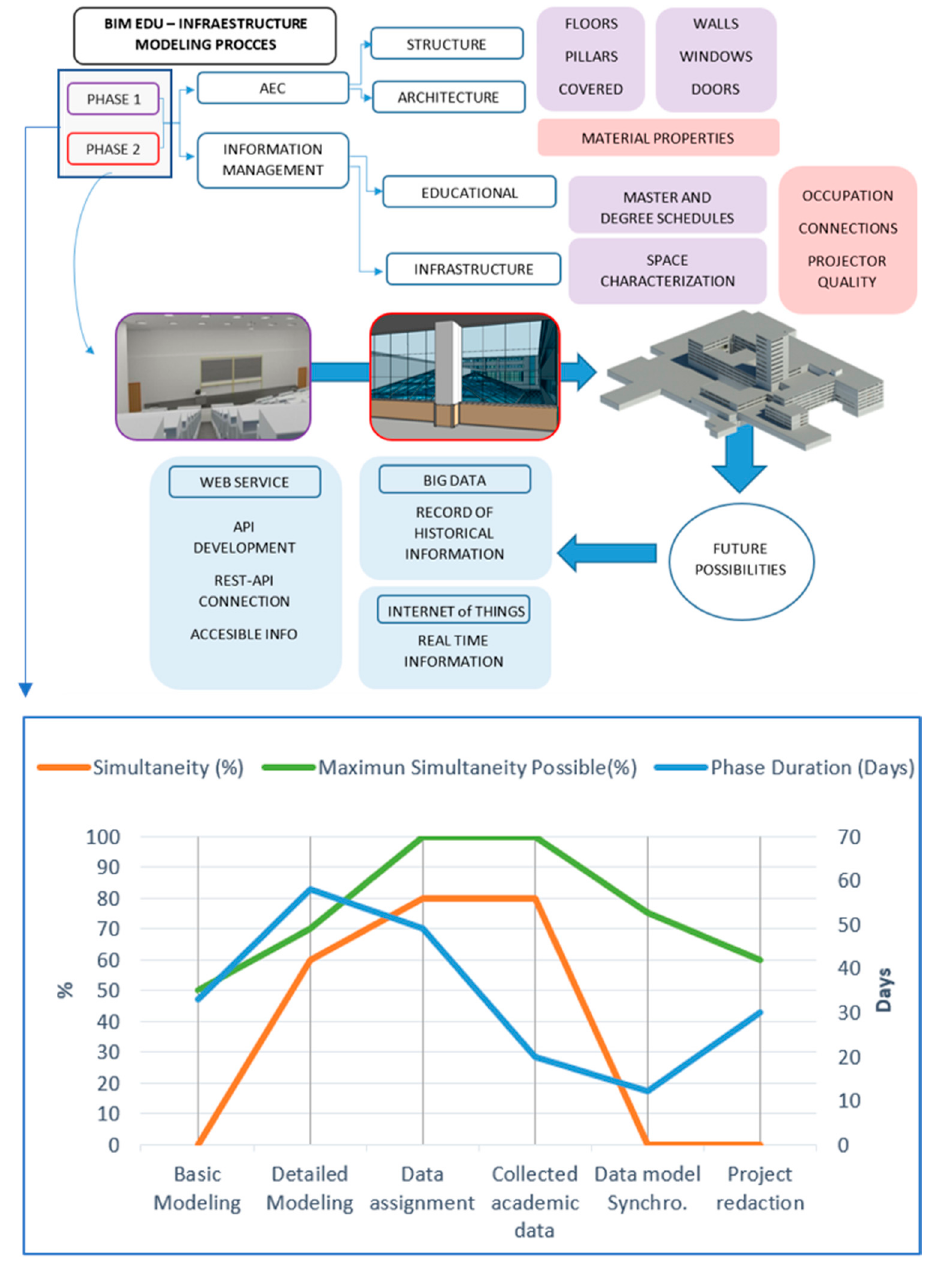
Figure 2. Modeling process and simultaneity.